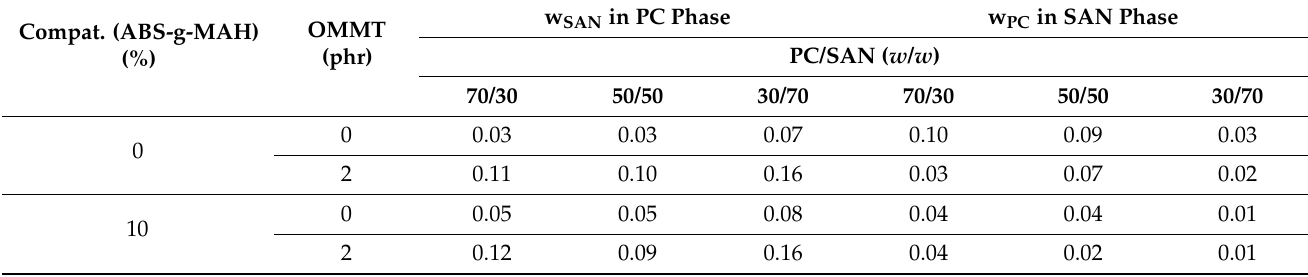
Table 4. Weight fraction of SAN in PC phase (w SAN ) and PC in SAN phase w PC , based on T g values from